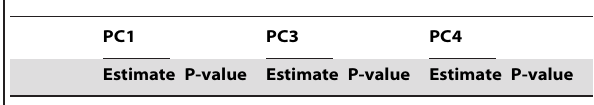
PC1 PC3 PC4 Estimate P-value Estimate P-value Estimate